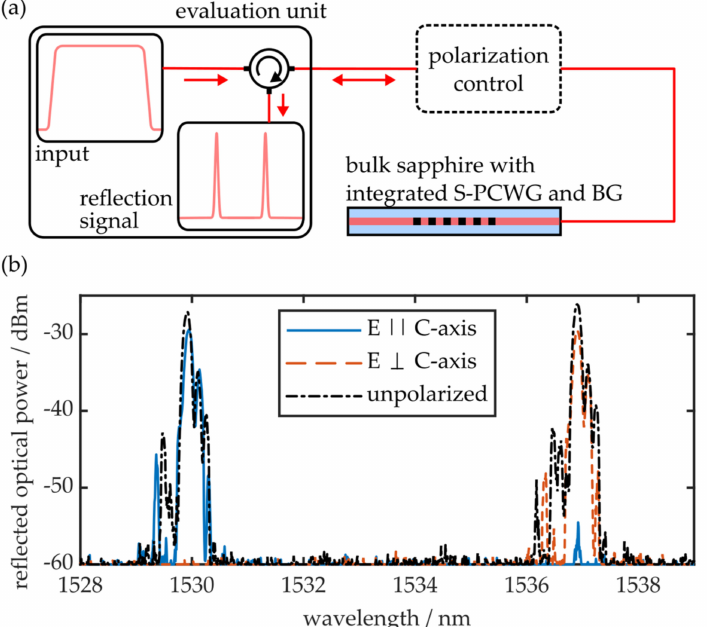
Figure 6. ( a ) Schematic of the employed evaluation setup for S-PCWGs with integrated Bragg grating structures. ( b ) Exemplary Bragg reflection signal when an S-PCWG with a modification distance of 5 µ m is excited with linearly polarized light, oriented in parallel or perpendicular to the sapphire crystal’s C-axis, as well as unpolarized